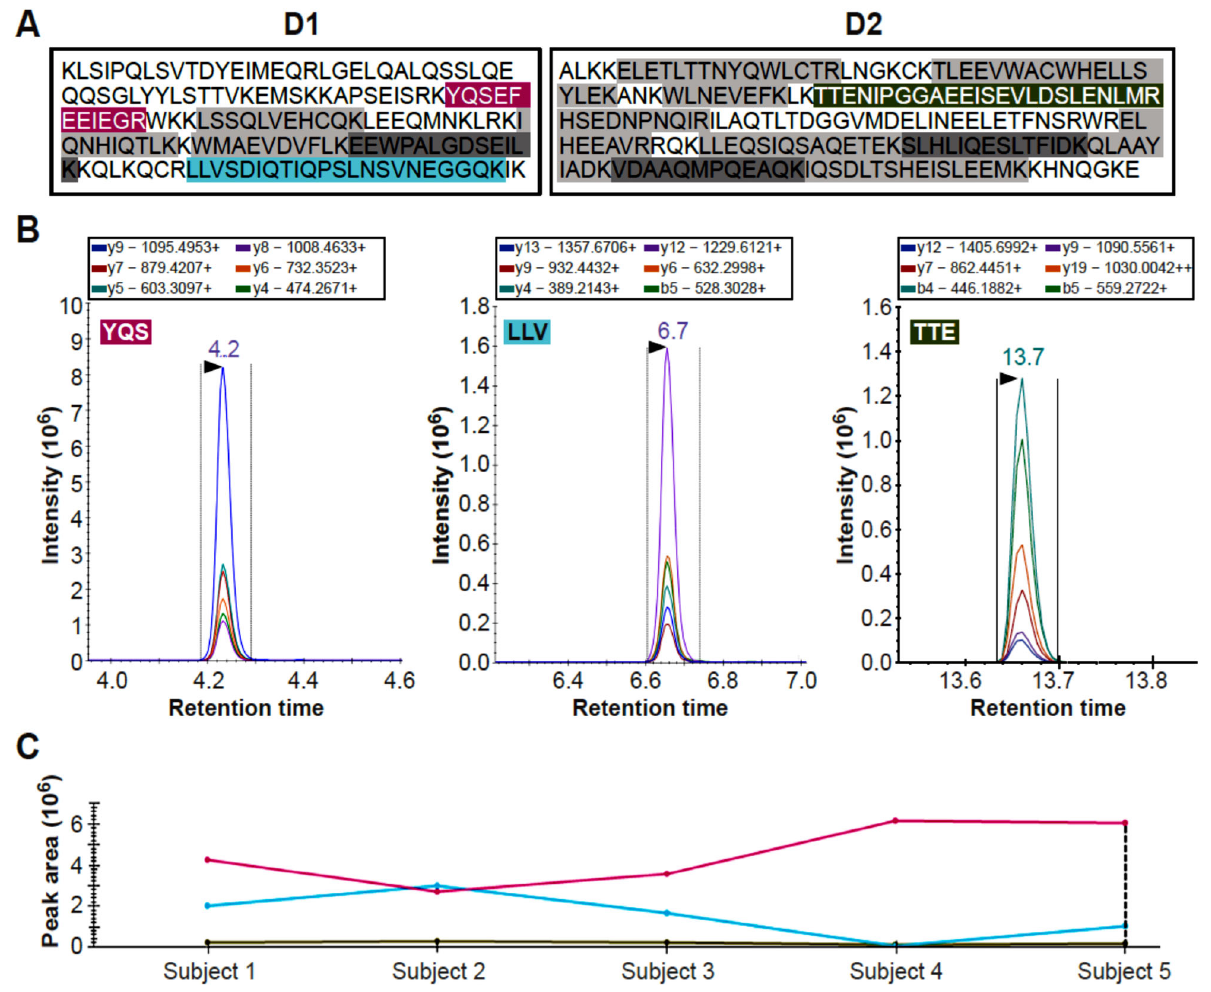
Figure 2. Detection of dystrophin peptides in healthy human donor plasma using targeted peptide LC ‐ MS/MS. Two PrESTs (D1 and D2), corresponding to the R6–R7 and R8–R10 subdomains of DYS Rod domain were used to set ‐ up a targeted mass spectrometry assay for detection in plasma from 5 healthy donors. Panel ( A ) shows the sequences for the D1 and D2 PrESTs, tryptic peptides that were developed into a multiplex targeted mass spectrometry assay. Those that were not detectable in control plasma are indicated in grey and those that were, are coloured. Panel ( B ) shows the peptide chromatograms of the mass transitions for the 3 tryptic peptide standards (YQSEFEEIEGR, LLVSDIQTIQPSLNSVNEGGQK and TTENIPGGAEEISEVLDSLENLMR) which were subsequently detected in plasma. Each coloured curve corresponds to a different transition, the colour code is maintained across the three graphs. Panel ( C ) shows summaries of the peak area across 5 healthy donor samples. The TTE tryptic peptide has the lowest intensity and area, followed by the LLV peptide. On the other hand, the YQS peptide has much better intensity. Lines have the same colours as the labelled peptides in Panel ( A